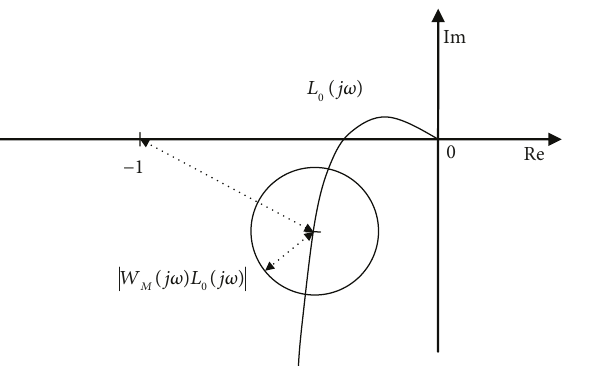
Figure 2: Graphical interpretation of robust stability condition for multiplicative uncertainty [55].